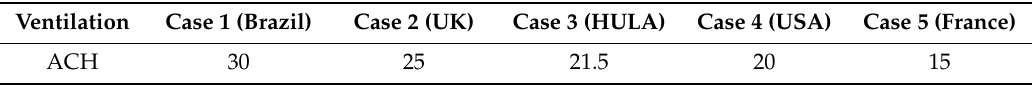
Table 5. Ventilation flows of the studied